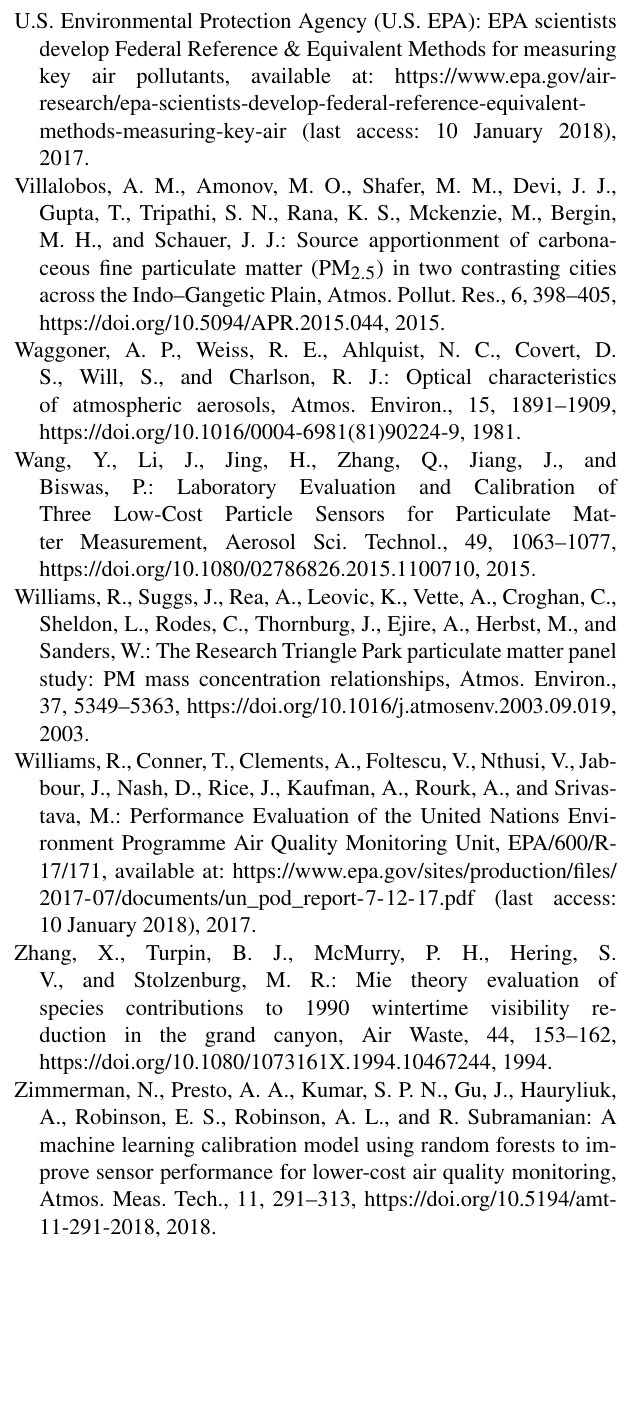
Table, available at: https://www.epa.gov/criteria-air-pollutants/ naaqs-table (last access: 10 January 2018), 2016b.